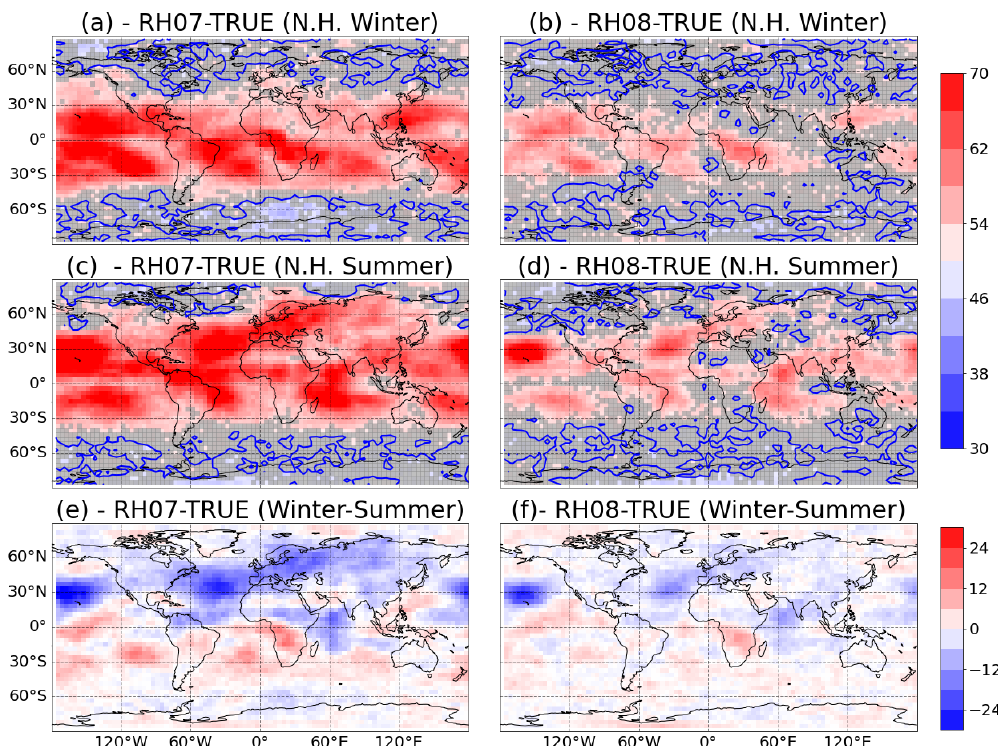
Figure 12. Percentage of correct identification between RH07 and TRUE catalog (a, c, e) and between the RH08 and TRUE catalogs (b, d, f) based on CME for the Northern Hemisphere winter (December, January, and February, a , b ), the Northern Hemisphere summer (June, July, and August, c , d ). The maps (e) and (f) show the difference between Northern Hemisphere winter minus summer in the percentage of correct identification. The gray shade indicates values which are below the 95% statistical significance level. The blue lines correspond to 50% of correct